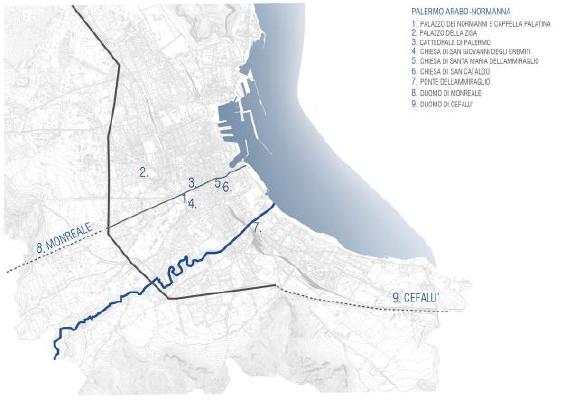
Figure 1. Location of UNESCO buildings.